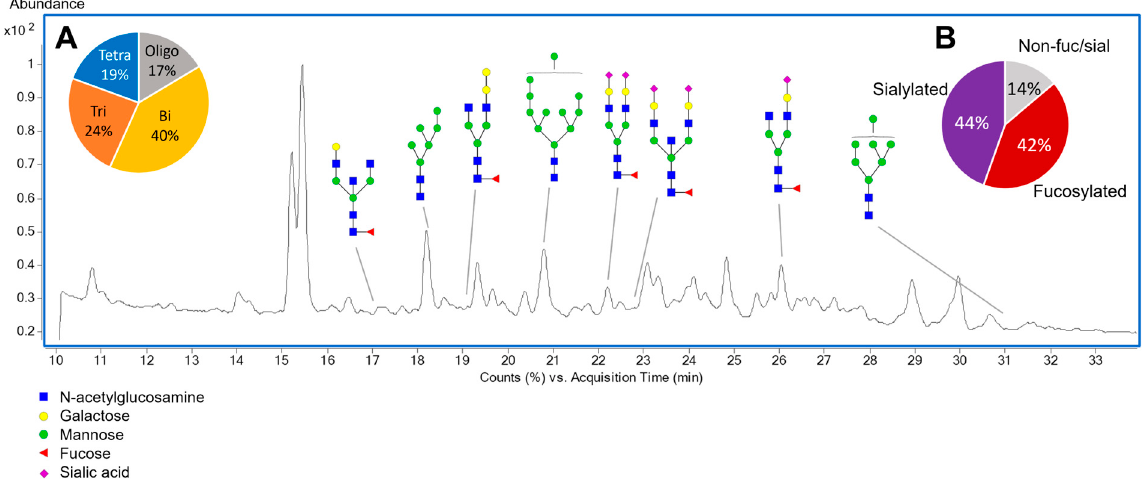
Figure 2. Representative chromatogram of the brain N-glycan profile representing selected statisti- cally significant structures in the three groups (CTRL, HFD, and MED). ( A ) Pie chart depicting the degree of the 72 N-glycans identified in hamster brain tissue. Oligo, oligomannose; Bi, biantennary; Tri, triantennary; Tetra, tetrantennary. ( B ) Pie chart depicting the percentage of fucosylated and sialylated N-glycans in hamster brain tissue. Non-fuc/sial, non-fucosylated and non-sialylated N-glycans. Structural symbols for the N-glycans are shown below the chromatogram.